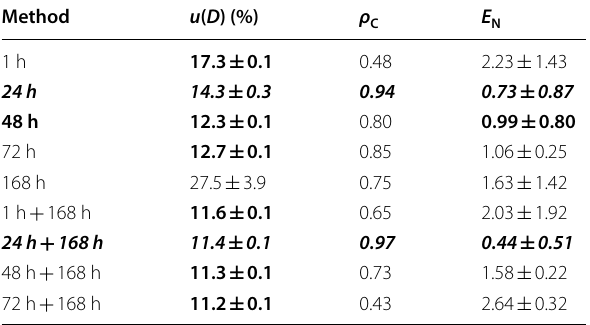
Table 3 The uncertainty u ( D ), Lin’s concordance correlation coefficient ρ and the normalized error E C dosimetry protocols for the kidneys